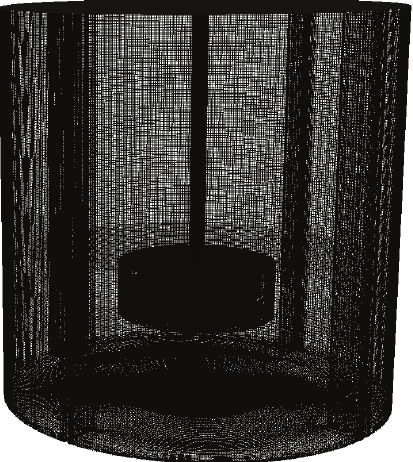
Figure 2: Mesh (LES 1) on the vessel wall and impeller with the highlighted sliding region around the impeller.